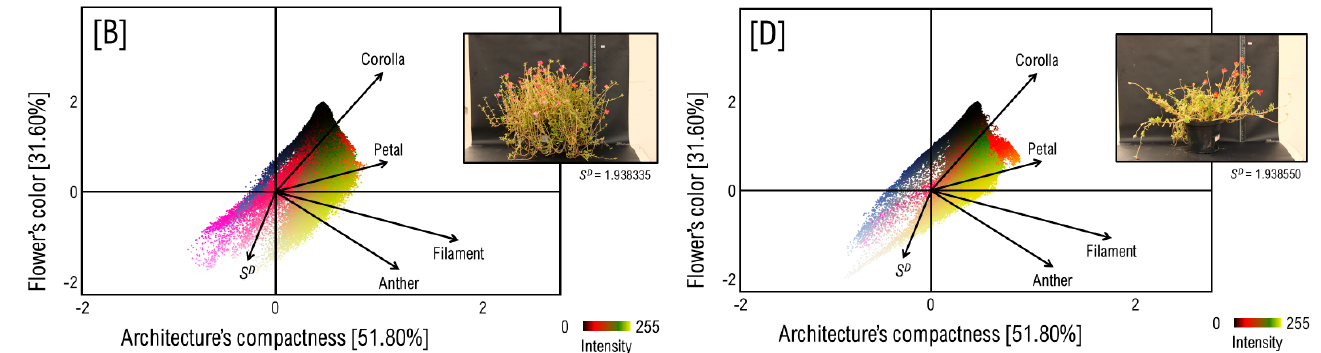
Figure 5. Mapping the botanical and computational features of flower and the architecture of red- flower samples of P. umbraticola . The sequence of alphanumerical symbols, from ( A – D ), relates to the increasing fractality of the pattern in the representation of the digital image.